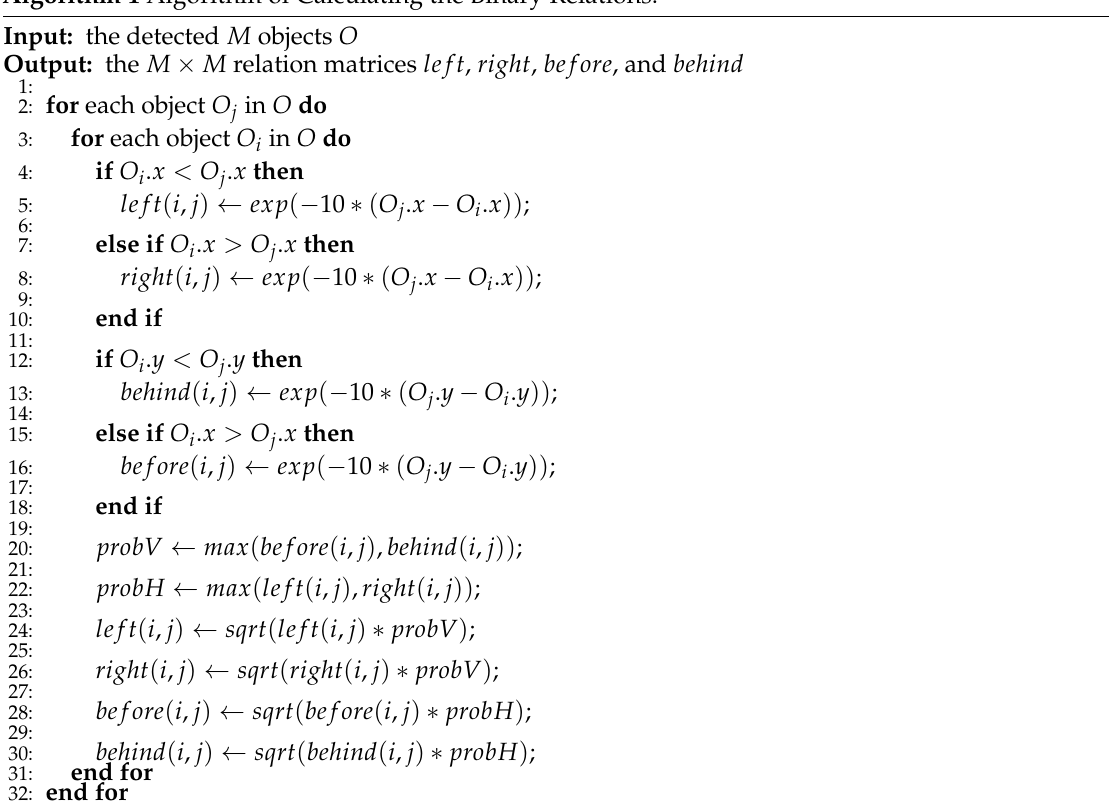
Algorithm 1 Algorithm of Calculating the Binary Relations.